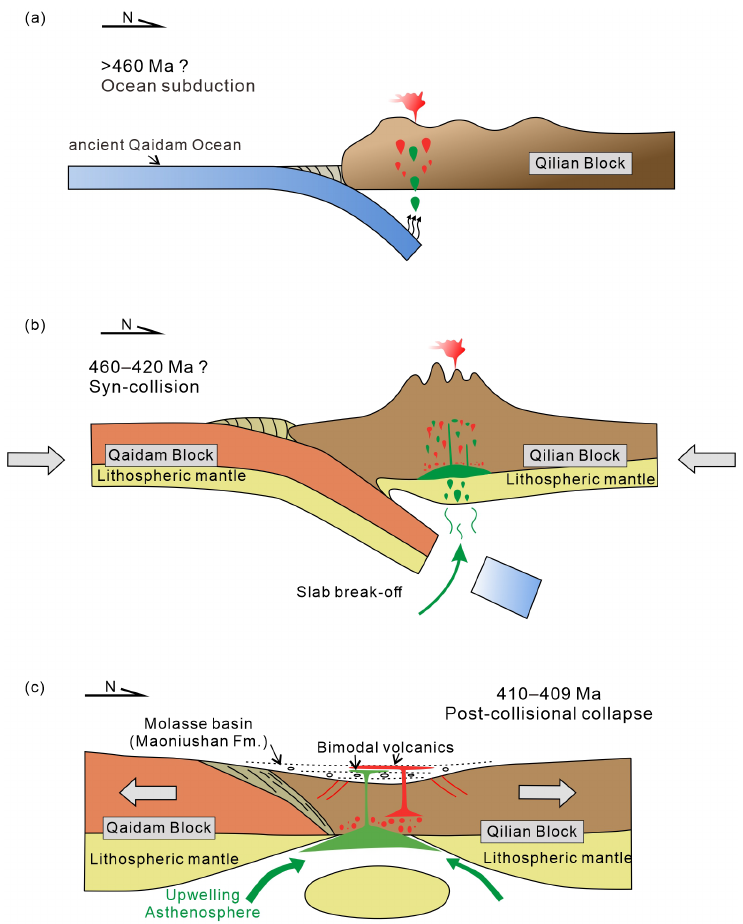
Figure 15. Schematic diagrams showing the tectonic evolution of NQ. ( a ) Oceanic subduction beneath the Qilian Block, ( b ) Qaidam Block collided with Qilian Block, and ( c ) the bimodal volcanic magmatism and delamination modal of the Maoniushan Formation in the post - collisional extensive stage [156 – 158 ]. The large number of Devonian magmatism related to the post - collision extensional regime marks the end of the Proto - Tethyan tectonic cycle and the beginning of the Paleo - Tethyan tectonic cycle. However, the existence of the Late Paleozoic to Early Mesozoic Paleo - Tethyan Ocean in the NQ is still a controversial scientific problem, thus leading to different viewpoints on the genesis of the Late Permian to Middle Triassic arc - related magmatic rocks. Some scholars have suggested that these rocks, including the Chahannuo gabbro, granite, and granodiorite (241 – 256 Ma); Chahanhe granodiorite and diorite (243 ± 1 Ma and 245 ± 0.7 Ma, respectively); and Guokeshan quartz diorite and mafic microgran- ular enclaves (MMEs) (ca. 247 Ma), are interpreted as a remote response to the northward subduction of the ancient Tethys Ocean (A’nyemaqen – Buqingshan Ocean). The NQ expe- rienced intracontinental rifting only during the Late Hercynian to Indosinian and did not